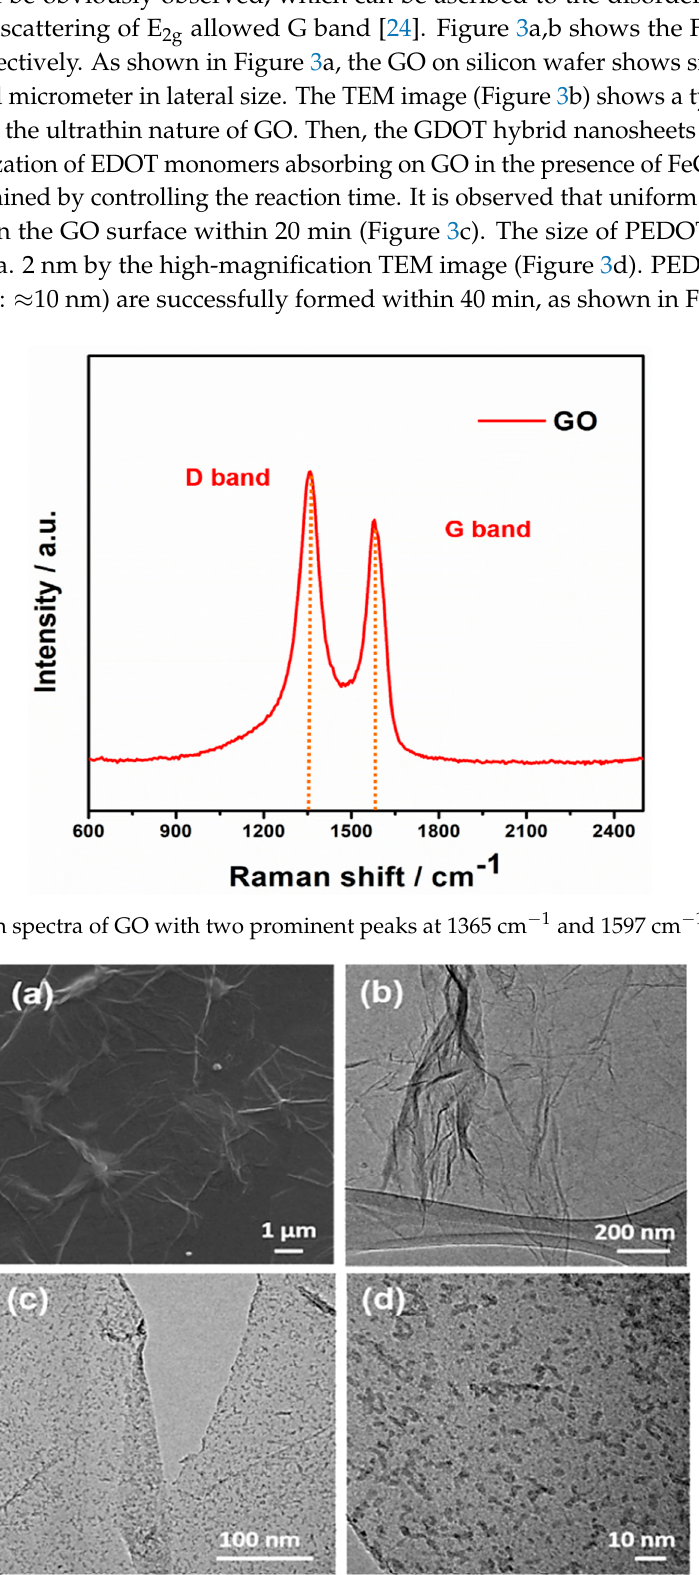
Figure 3. Characterizations of GO and GDOT: FE-SEM ( a ) and TEM ( b ) images of GO; TEM images of GDOT obtained within reaction time of 20 min ( c , d ) and 40 min ( e , f ). Furthermore, the PEDOT fibers were prepared without adding GO, and their TEM image is presented in Figure 4. The results suggest from another point of view that the PEDOT fibers were uniformly deposited on ultrathin graphene oxide (GO) nanosheets by a facile in situ polymerization process.